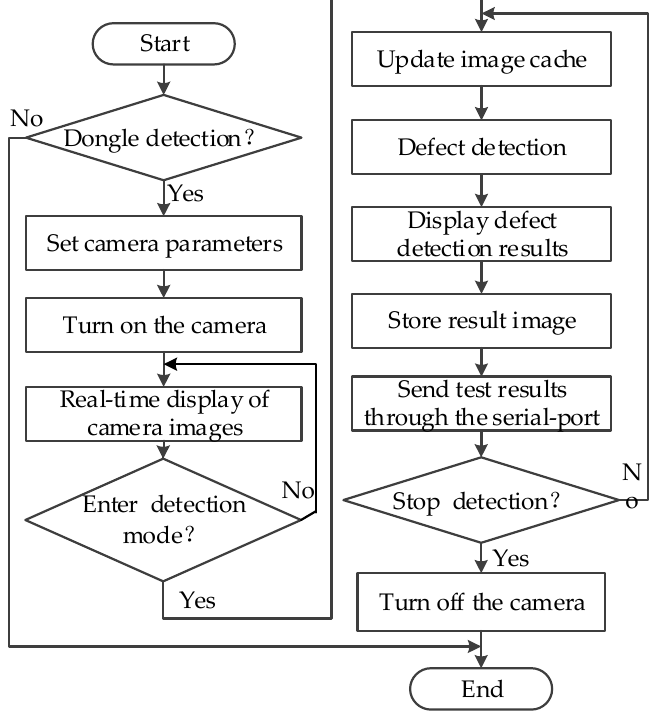
Figure 5. Flowchart of the software system.